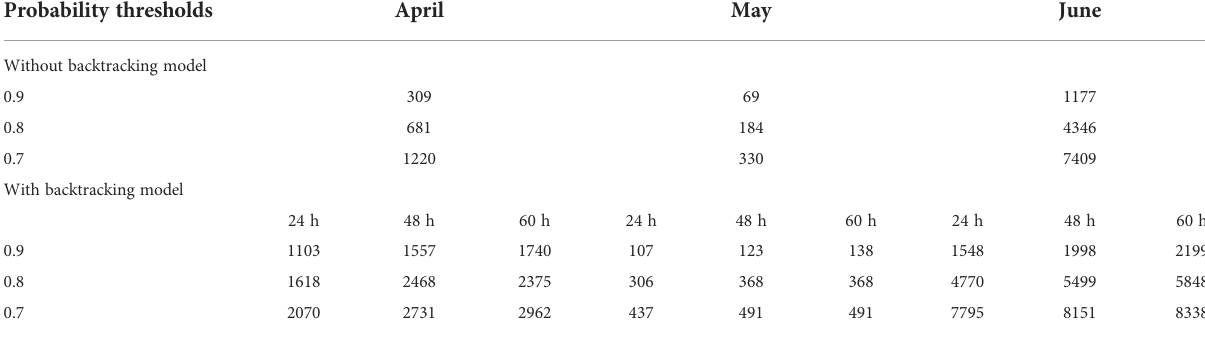
TABLE 4 Model-based estimates of areas (km 2 ) in priority protection areas based on the probability thresholds of 0.7, 0.8, and 0.9. Probability thresholds Without backtracking